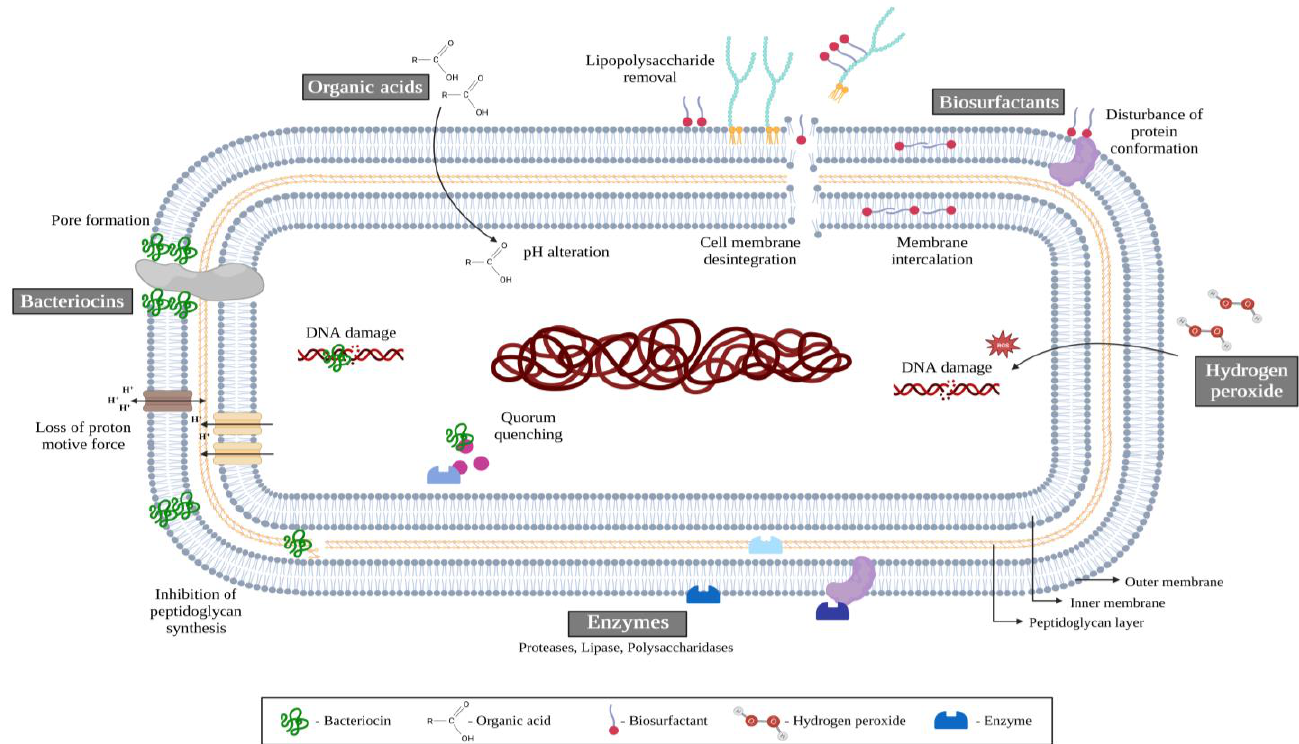
Figure 3. Mechanisms of action of probiotics against foodborne microorganisms. Bacteriocins can induce cell death by dissipating the proton motive force and disrupting bacterial membranes. Organic acids lead to a decrease in pH, impairing the growth of microorganisms. Biosurfactants affect cell surface compounds, causing membrane disintegration. Hydrogen peroxide can damage biomolecules such as DNA. Enzymes can target and damage extracellular proteins, exopolysaccharides, DNA, or QS molecules. Adapted from [30,43] .